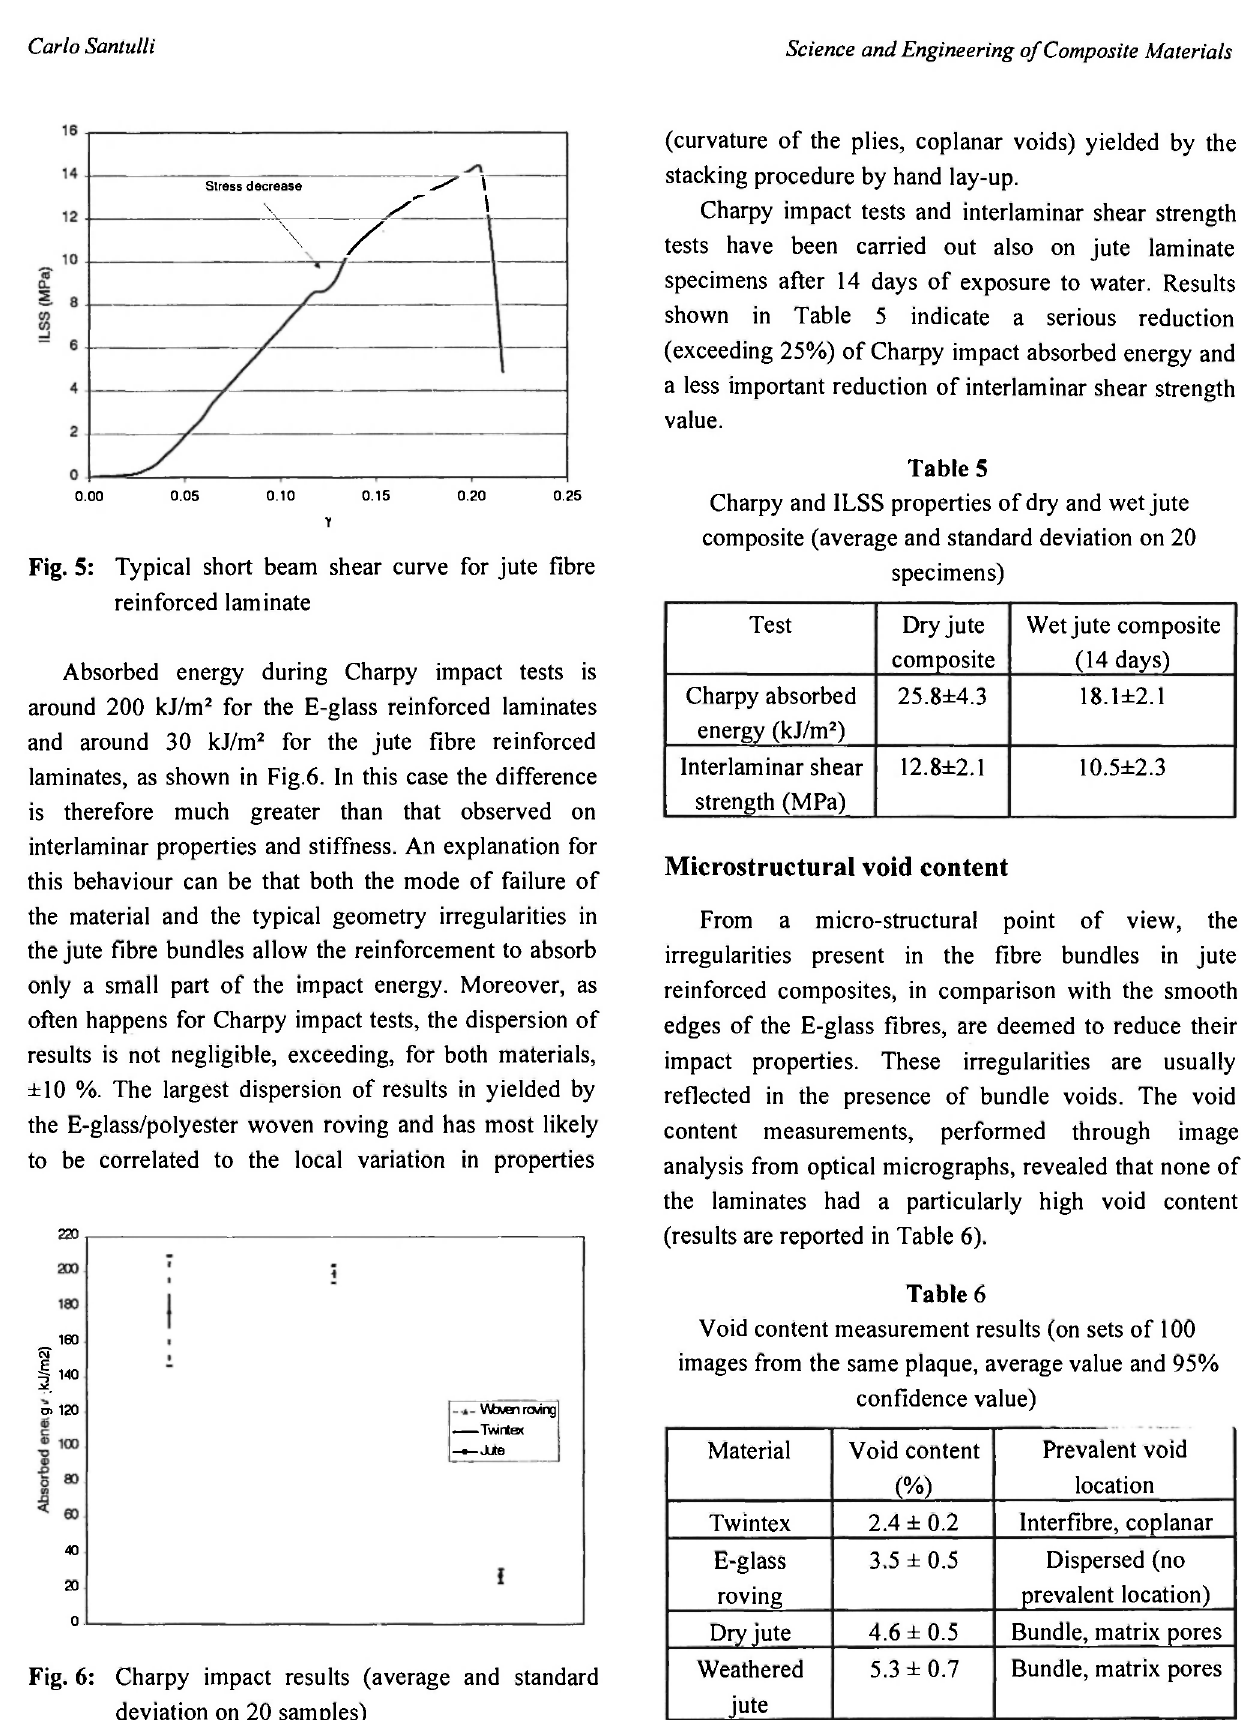
Fig. 6: Charpy impact results (average and standard deviation on 20